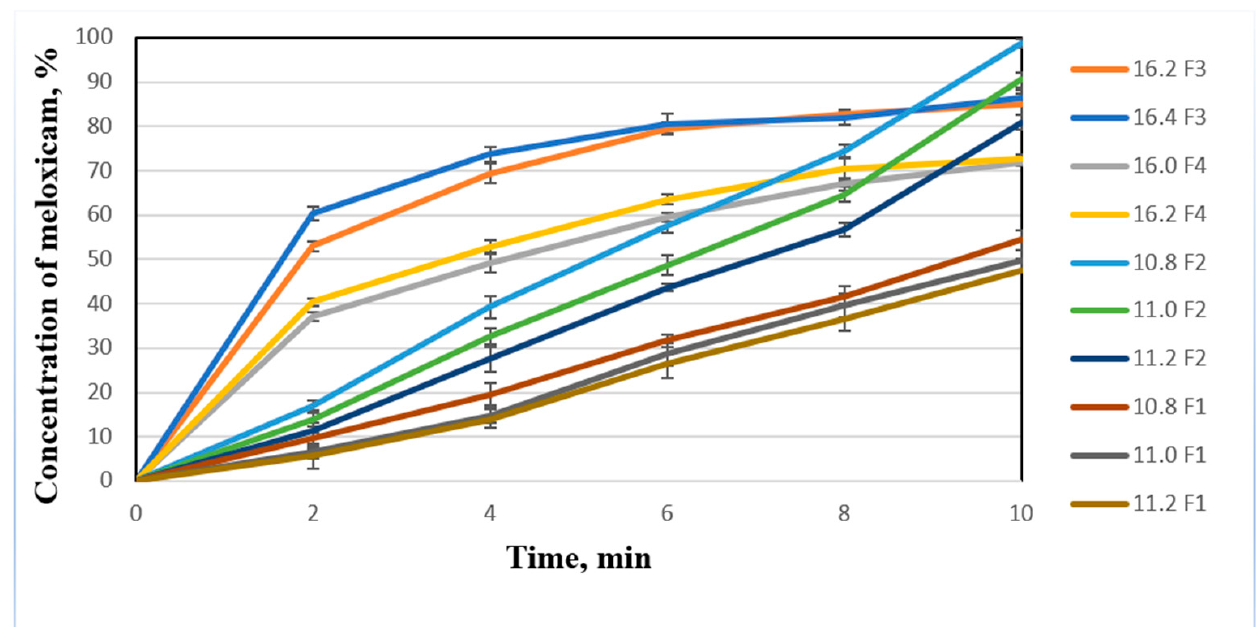
Figure 2. Dissolution profile of meloxicam tablets ( n = 3, data presented as mean ± SEM. F1 = formulation without disintegrant, F2 = formulation containing 7% chitosan, F3 = formulation containing 7% croscarmellose sodium, F4 = formulation containing 7% sodium starch glycolate).